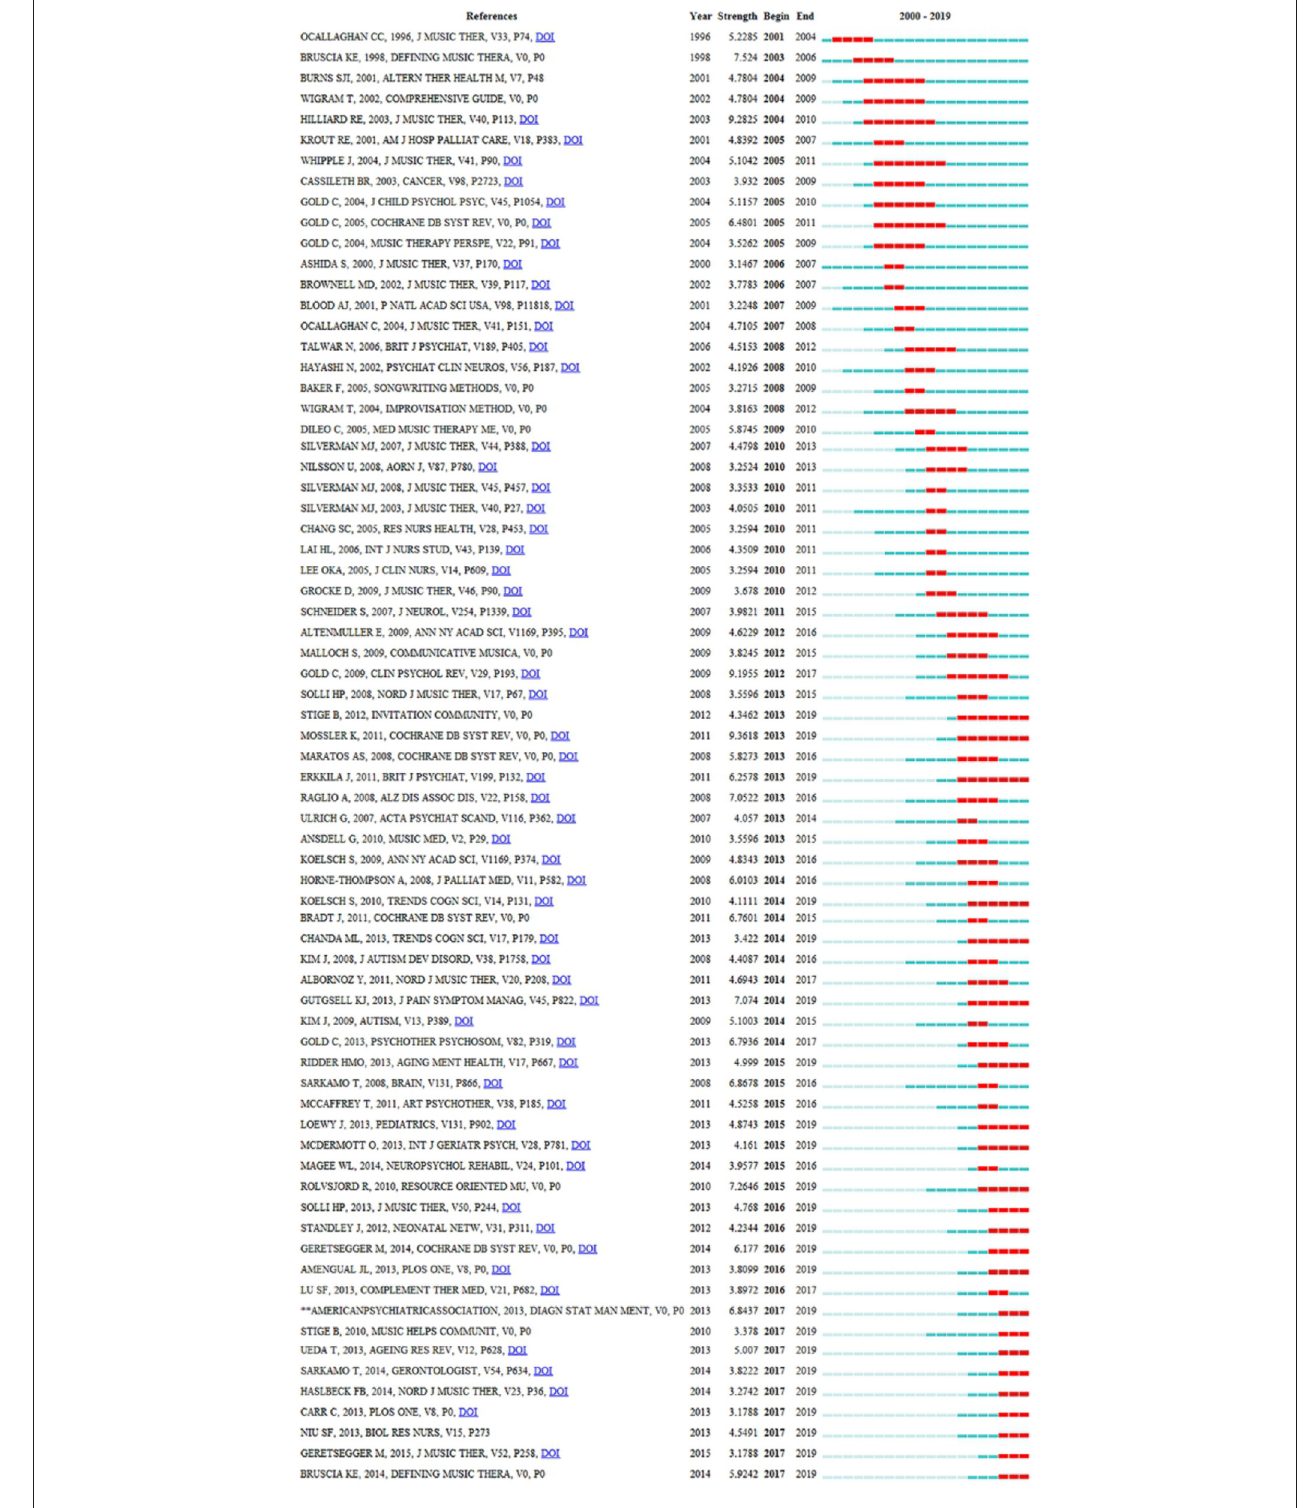
FIGURE 9 | The strongest citation bursts among the top 71 references. The red measures indicate frequent citation of studies, and the green measures indicate infrequent citation of studies.